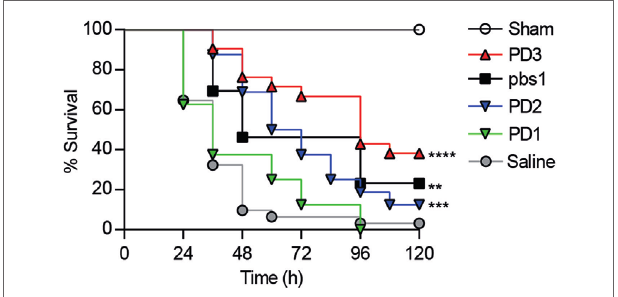
FigUre 5 | Comparative therapeutic effects of intravenous ( i.v. ) infused CD6-derived peptides on mouse survival following cecal ligation and puncture (CLP)-induced sepsis. C57BL/6J mice were i.v. infused with saline ( n = 31) or single 6 mg/kg doses of unlabeled CD6 (PD1, n = 8; PD2, n = 16; PD3, n = 22) or DMBT-1/SAG (pbs1, n = 13) derived peptides 1 h post CLP induction. A sham group ( n = 3) was included, which received saline. The